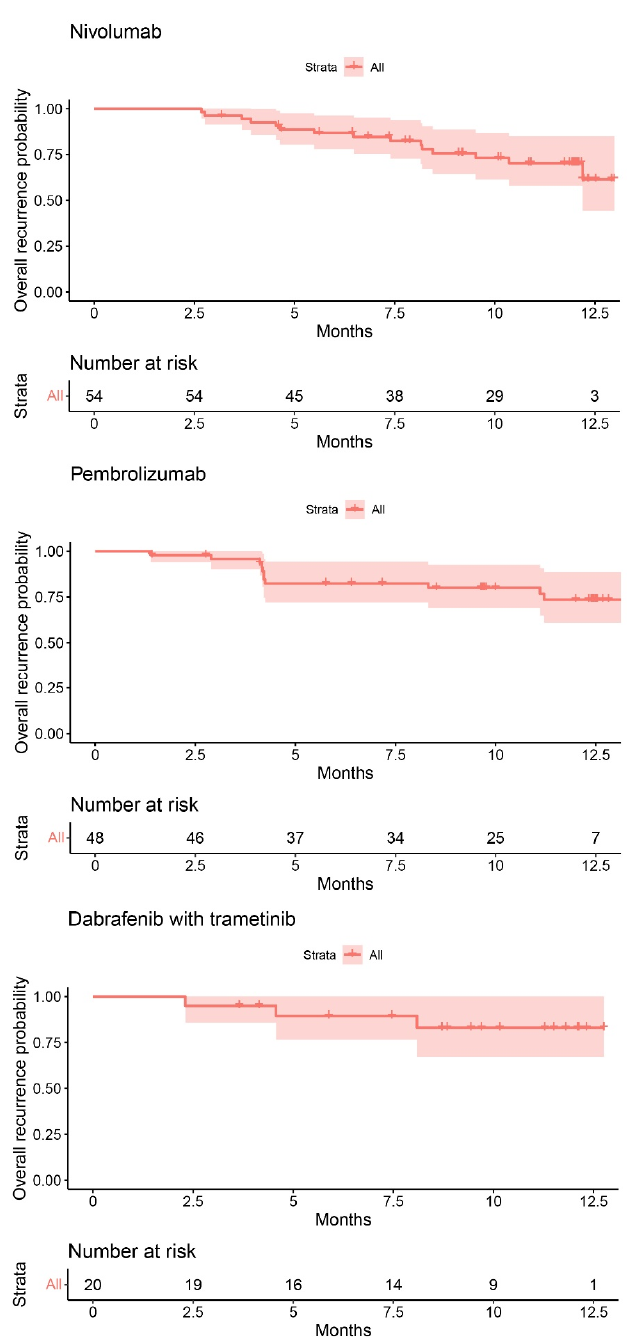
Figure 4. Kaplan–Meier curves representing the recurrence-free survival (RFS) of nivolumab, pem- brolizumab, and dabrafenib plus trametinib 1-year RFS was 70.3% (95% confidence interval (CI): 58.1–85.0) for nivolumab, 72.4% (95% CI: 60–87.3) for pembrolizumab, and 83.0% (95% CI: 67.1–100) for dabrafenib plus trametinib.